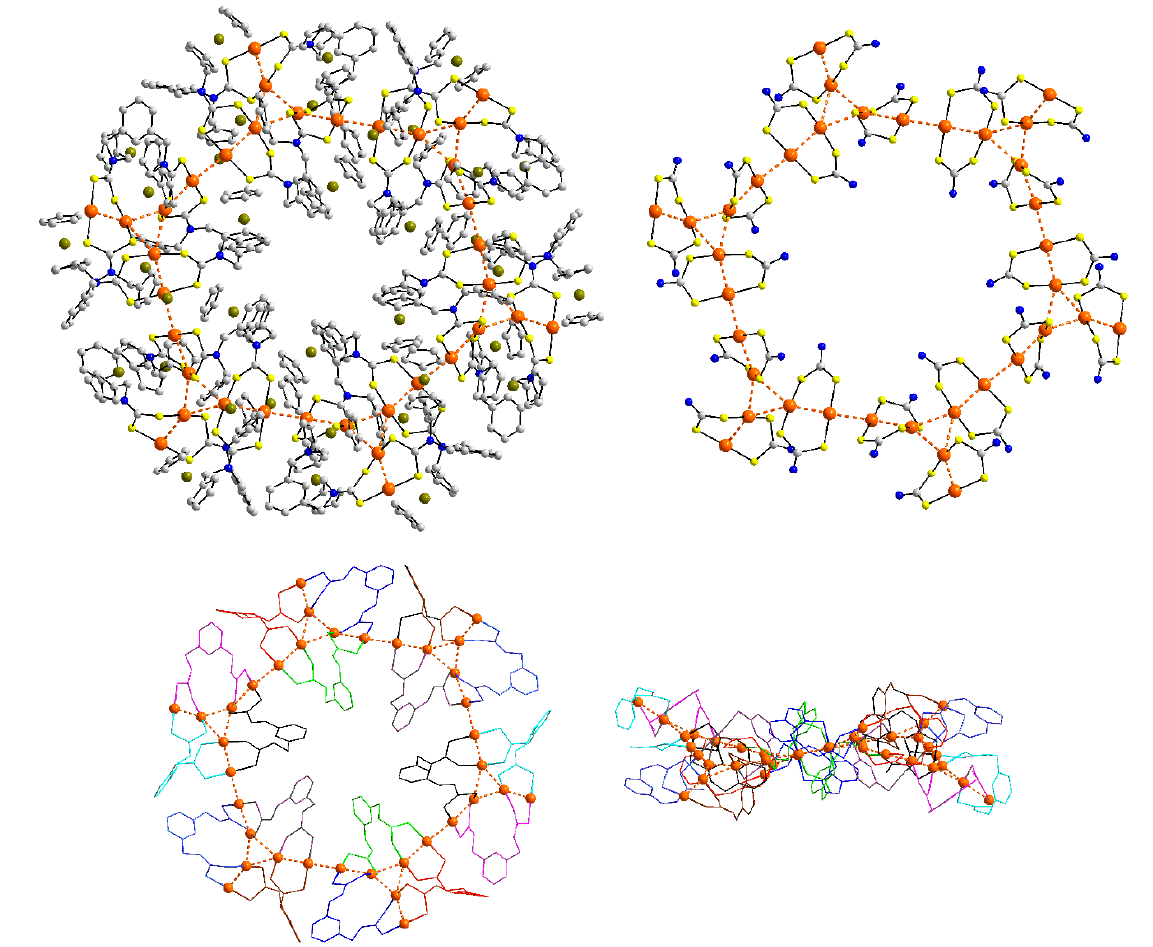
Figure 10. Views of the molecular structure of [Au 36 (L 12 ) 18 ] 8+ in the crystal of 38 and simplified versions. In the lower views, each L 12 di-anion has been colour-coded.